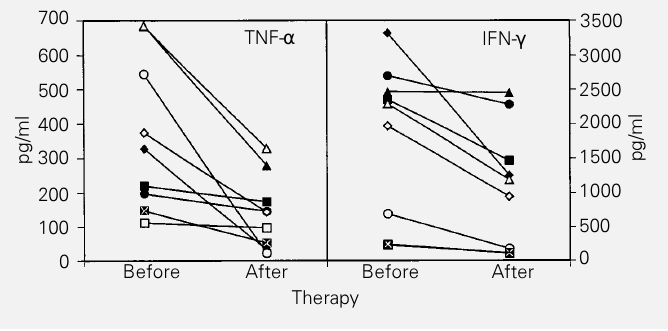
Figure 2 - TNF- a and IFN- g levels in Leishmania antigen-stimulated PBMC before and after therapy in patients with tegumentary leishmaniasis. P = 0.02 for TNF- a levels before and after treatment (Mann-Whitney test). Different symbols repre- sent the